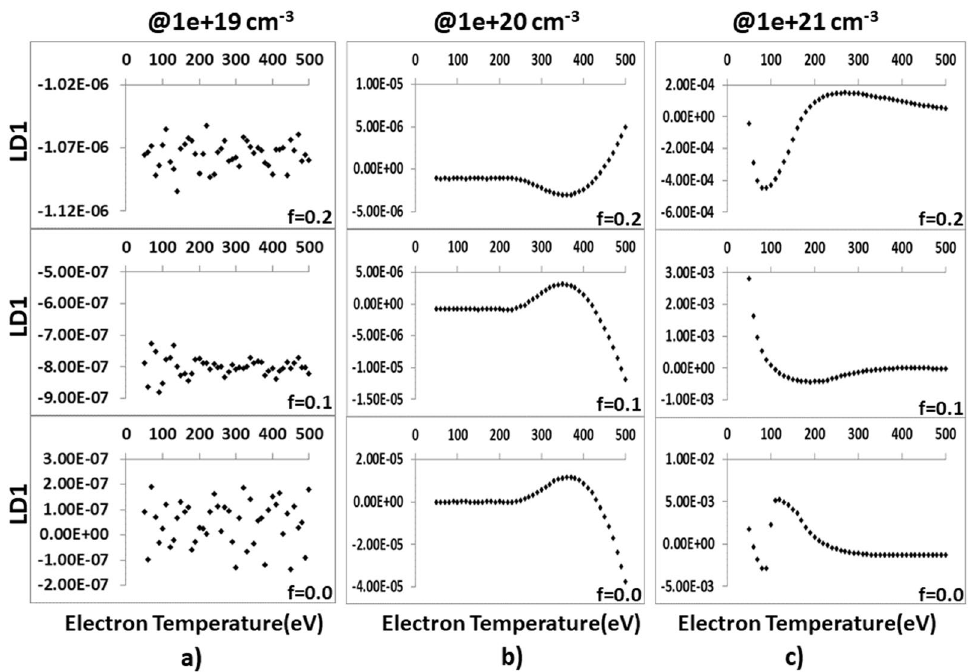
Figure 7. |LD1 > coefficients versus electron temperatures graphs for certain electron densities and beam